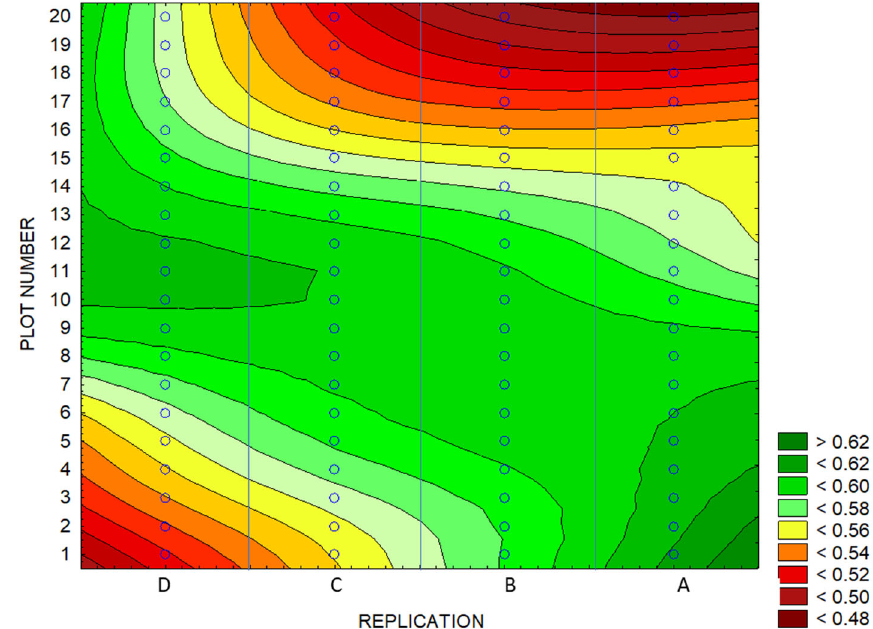
Figure 15. Contour map of BNDVI. Blue circles illustrate plot centers.